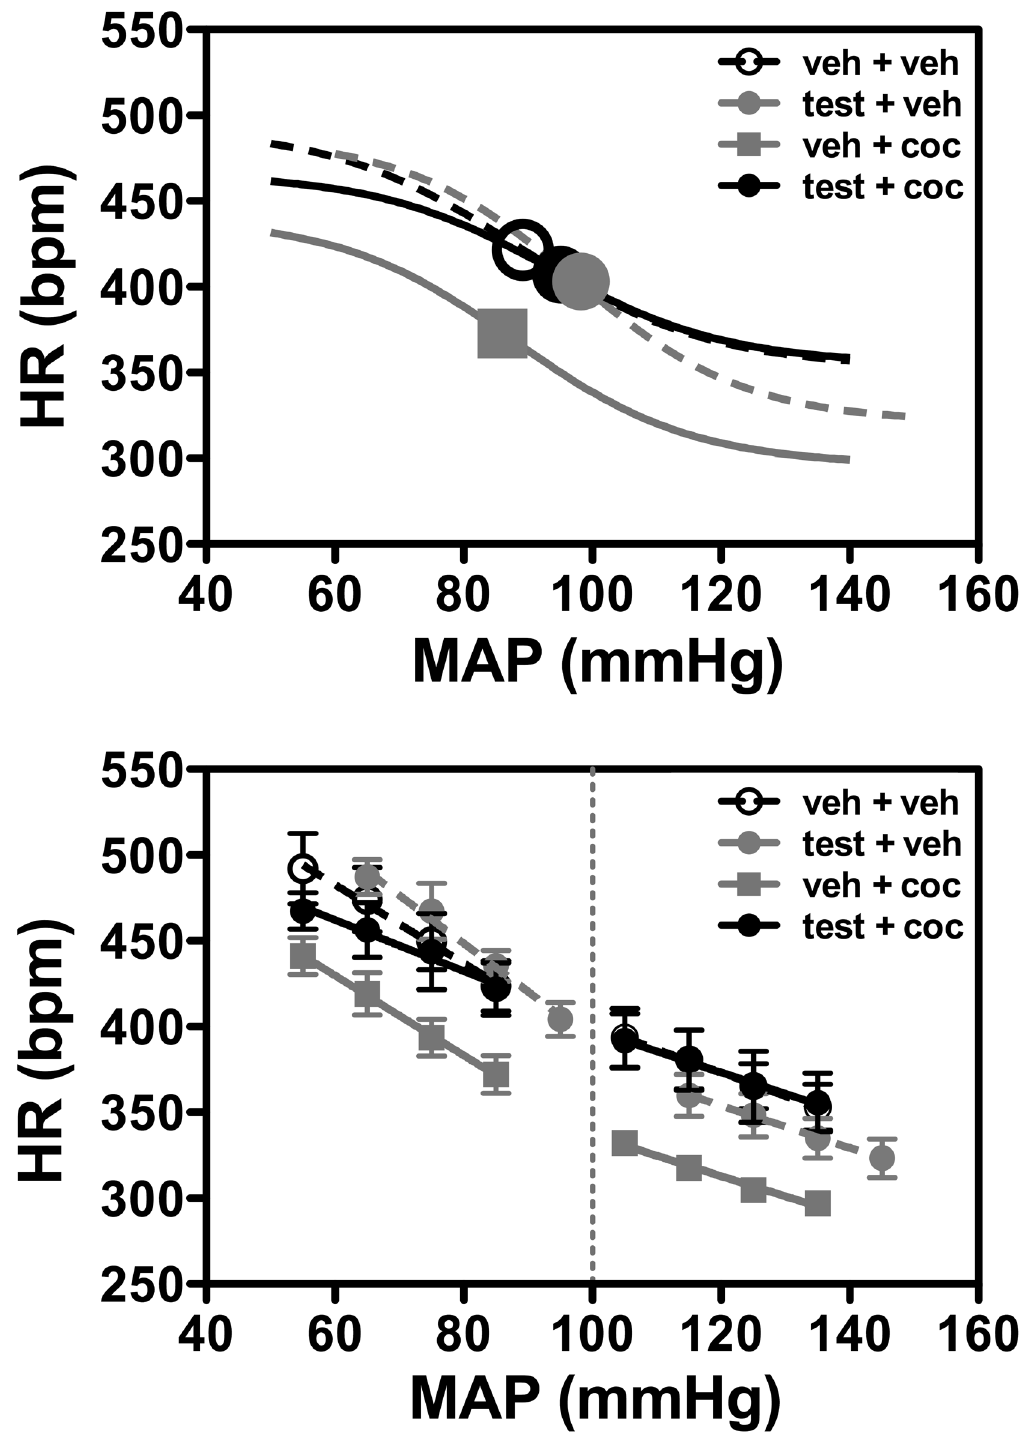
Figure 2. Nonlinear (top) and linear (bottom) regression analysis of the baroreflex correlating mean arterial pressure (MAP) and heart rate (HR) values in adolescent animals subjected to treatment for 10 consecutive days with testosterone and cocaine alone and in combination. Symbols on sigmoid curves (top) indicate the respective BP 50 . Circles represent the mean and bars the SEM on linear regression curves (bottom). veh – vehicle, test - testosterone and coc – cocaine. Increase or decrease in the MAP was induced by intravenous infusion of phenylephrine and sodium nitroprusside, respectively.